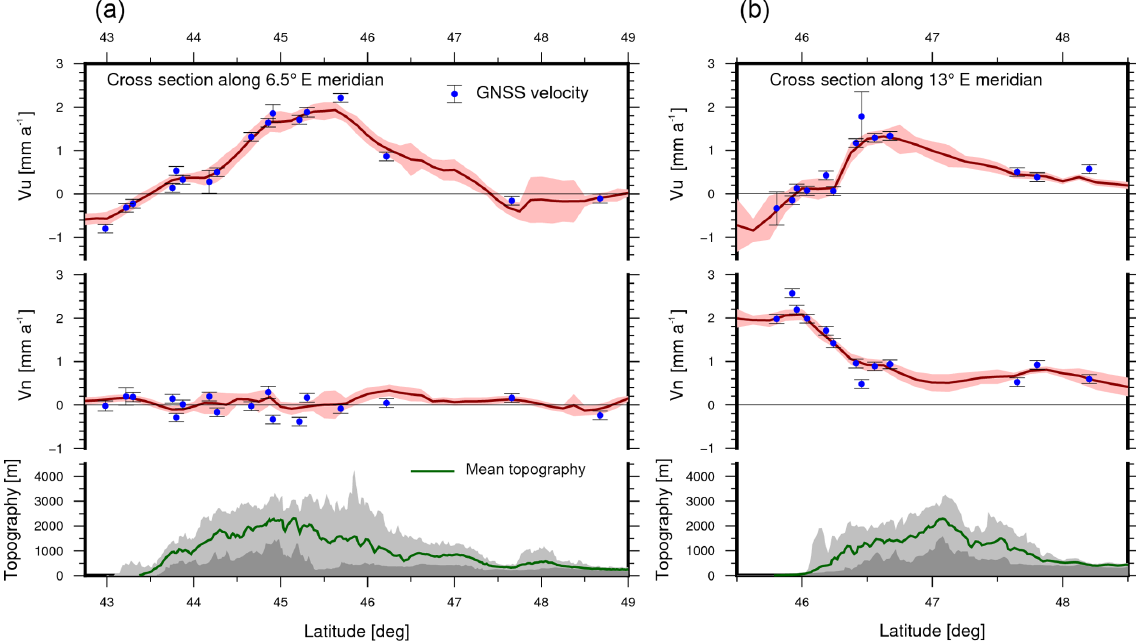
Figure 13. Velocity profiles in the Western Alps (cross section along longitude 6.5 ◦ E, a ) and in the Eastern Alps (cross section along longitude 13 ◦ E, b ). Blue dots with error bars represent the observed station velocities (with 68% confidence). Red lines represent the north ( V n ) and the vertical ( V u ) components of the deformation model with their uncertainty (light red stripe). Green line shows the average topography in the profile swath, with light and dark grey shadows showing the maximum and minimum elevations, respectively.